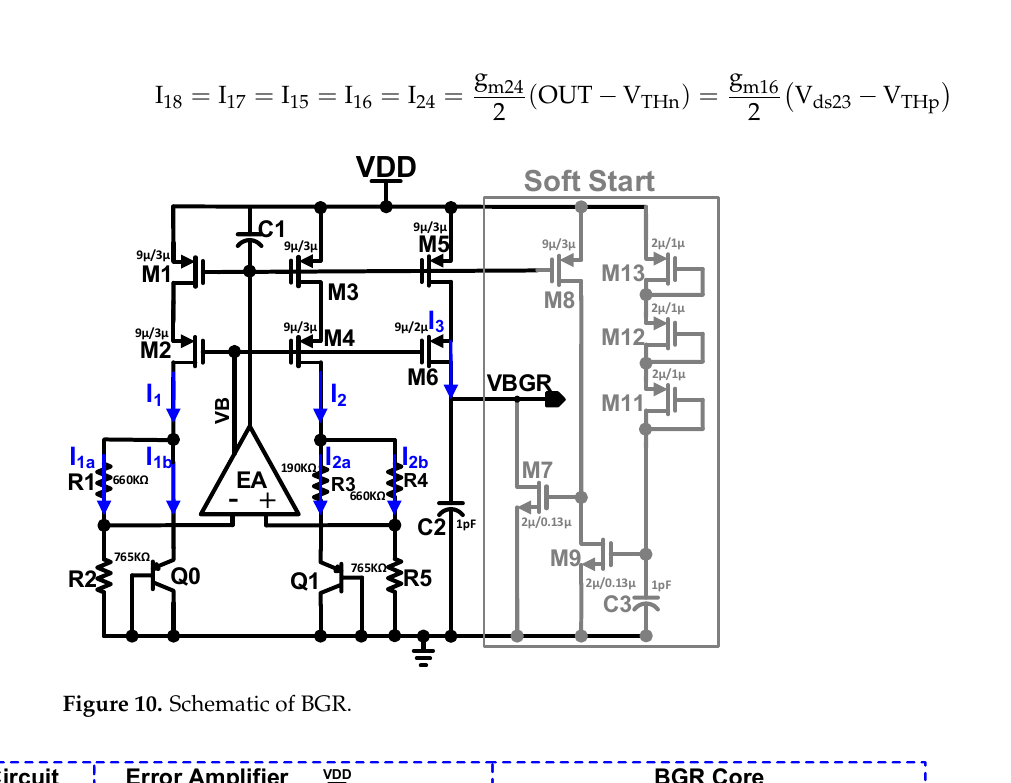
9 of 15 Figure 9. Schematic of variable delay cell. 3.5. Error Amplifier-Based Bandgap Reference Voltage Generator Reference voltage generators are required to stabilize the overall PVT variation, and also need to be implemented without modifying the fabrication process [21–23]. The bandgap reference voltage generator (BGR) is a popular reference voltage generator that successfully achieves the requirements [24,25]. Low power and low voltage operation are the characteristics of reference voltage generators. The error amplifier feedback keeps the same voltage level at both inputs of EA, and R3 generates the voltage difference between